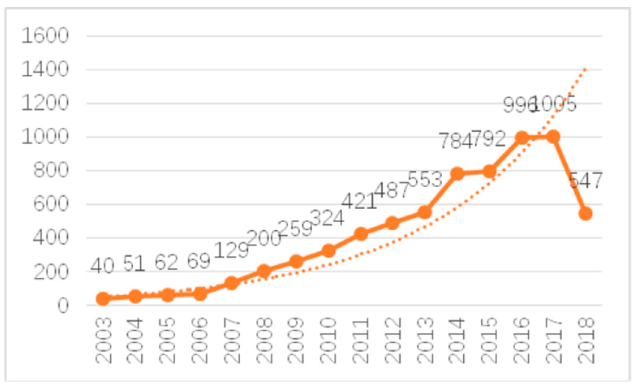
Figure 1. Annual number of published articles.